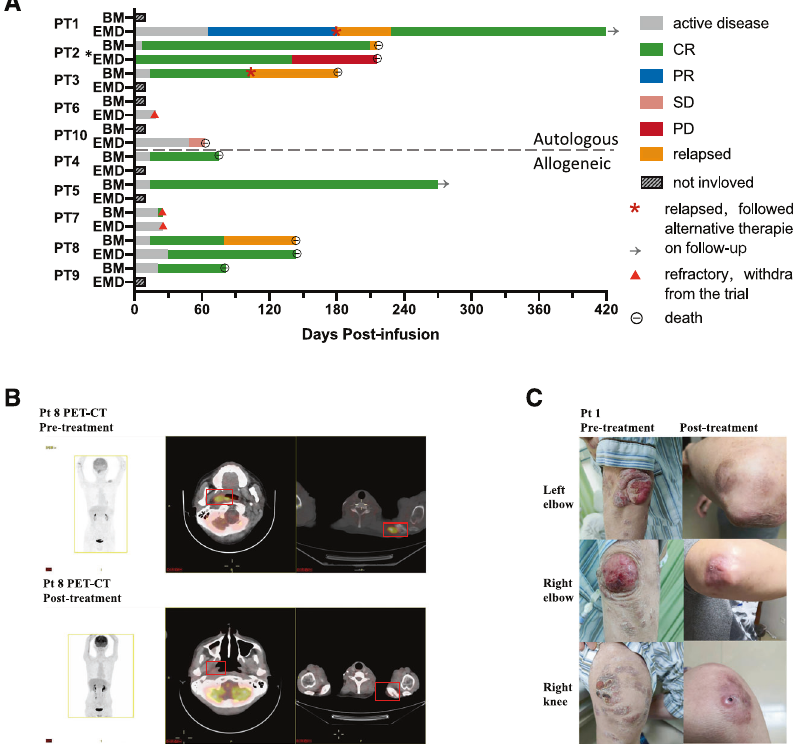
Fig. 2 Clinical response to anti-CD7 CAR-T cells. A The clinical responses of patients ’ BM and EMD post anti-CD7 CAR-T infusion are shown by swimmer plots. For patients without BM in fi ltration or EMD, striped bars are presented. PT patient, BM bone marrow, EMD extramedullary disease, CR complete remission, PR partial response, SD stable disease, PD progressive disease. * EMD did not existed during screening in patient 2 and she achieved MRD- CR after infusion. On the 140th post infusion, extramedullary recurrence occurred in the gastric wall,